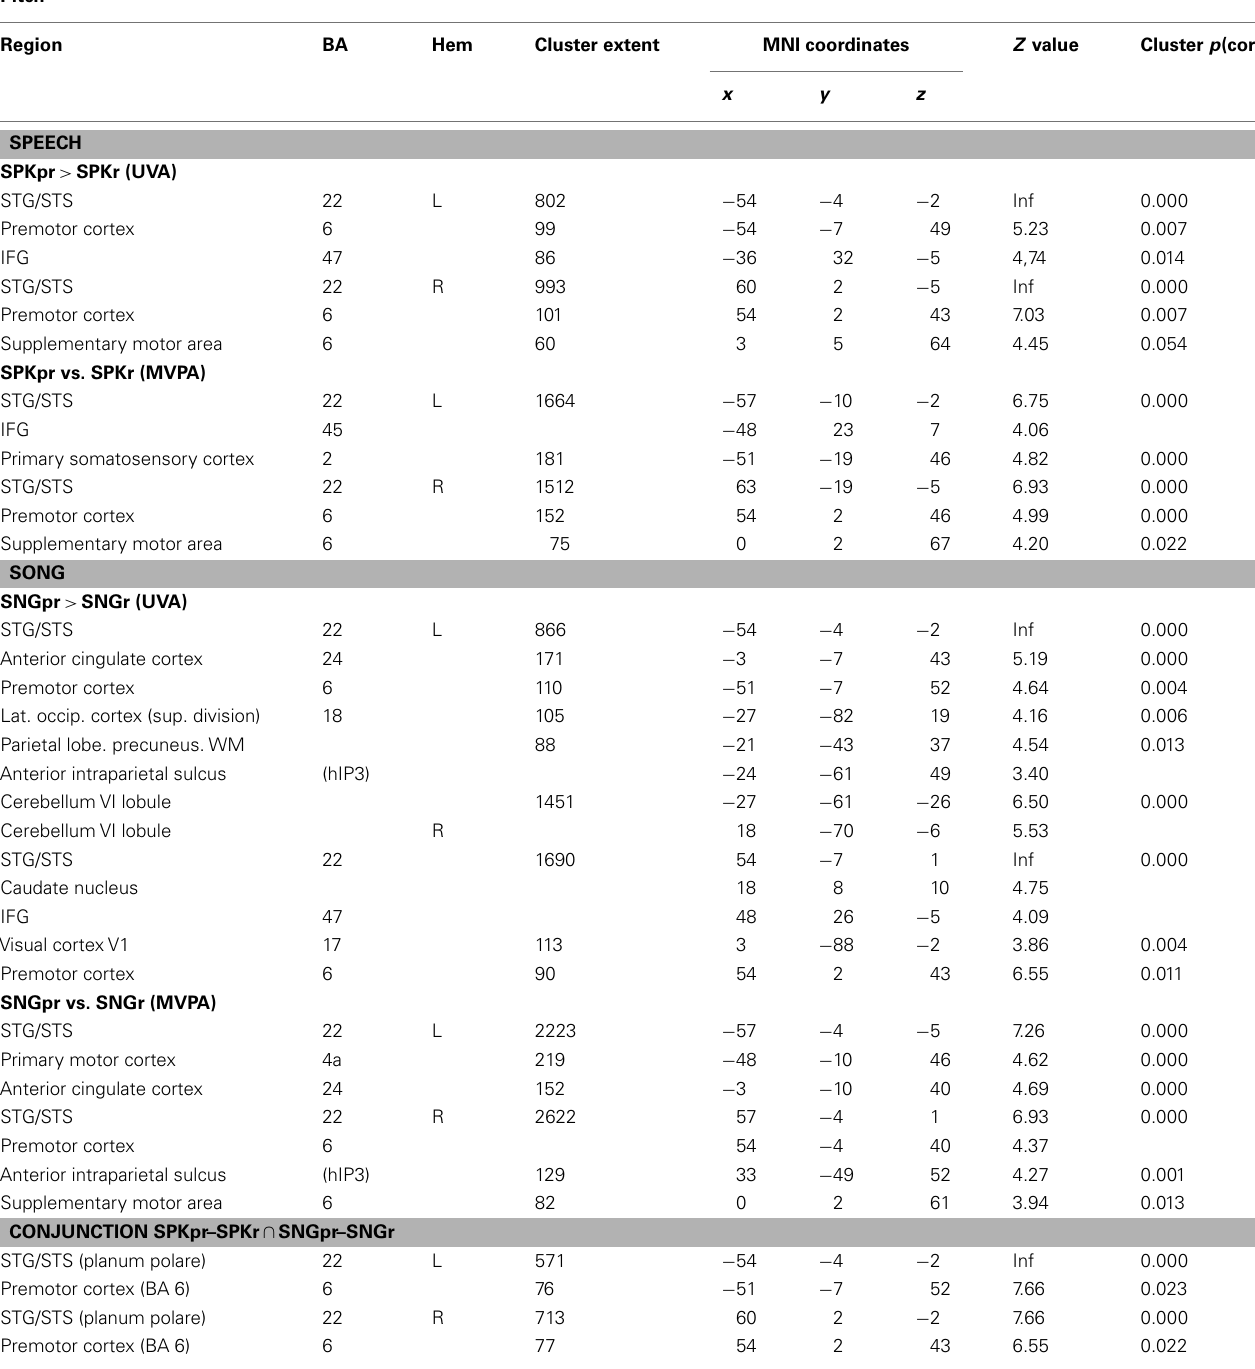
Table 2 | Brain areas involved in the processing of pitch patterns in song and